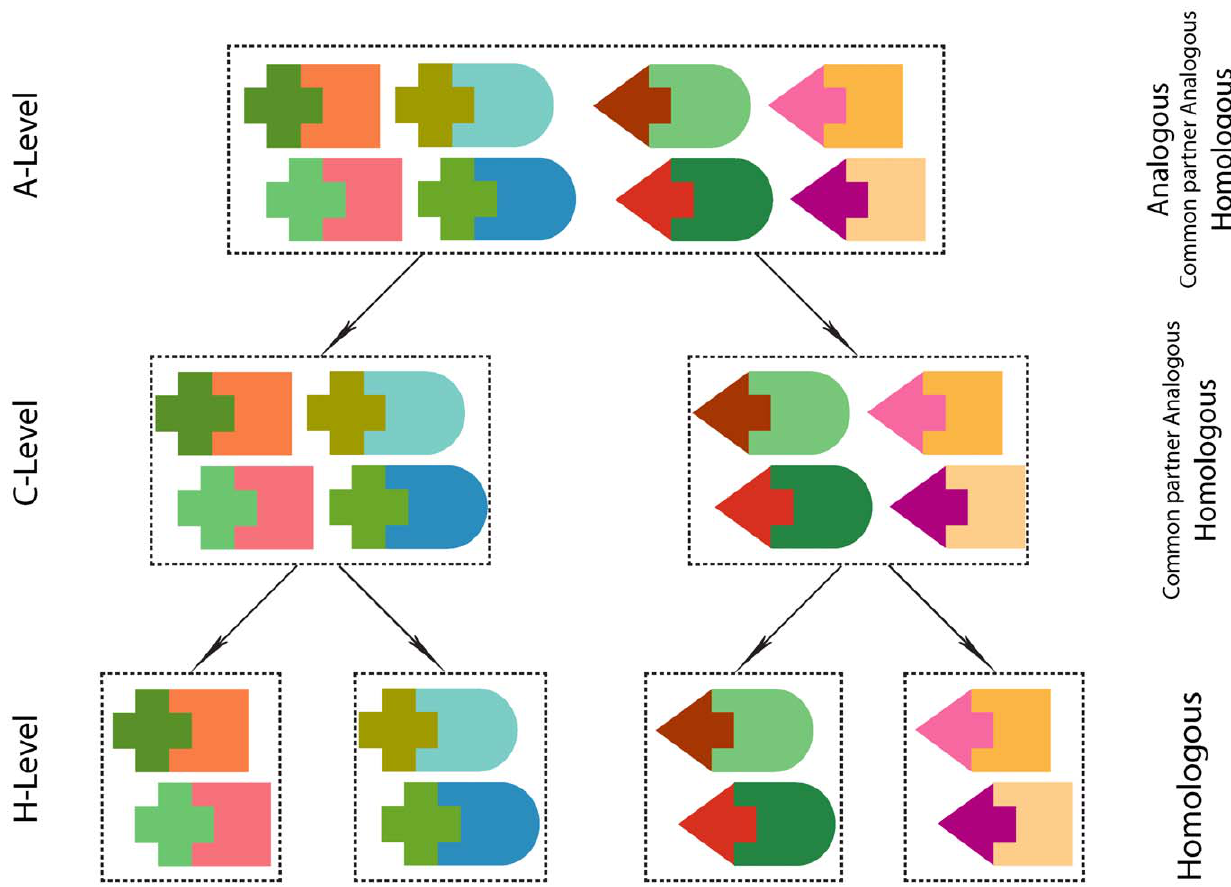
Figure 3. Hierarchical classification of interaction interfaces. Similar shapes correspond to homologous proteins. Three levels of structurally similar interaction interfaces are defined. A single cluster at H-level, C-level, and A-level can include homologous, common partner analogous, and analogous interfaces, correspondingly.